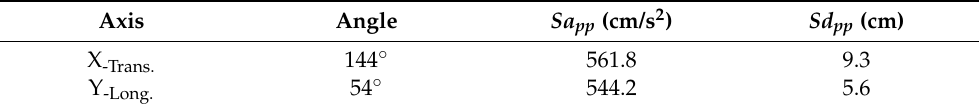
Table 4. Performance point values from the principal axes of the studied building.